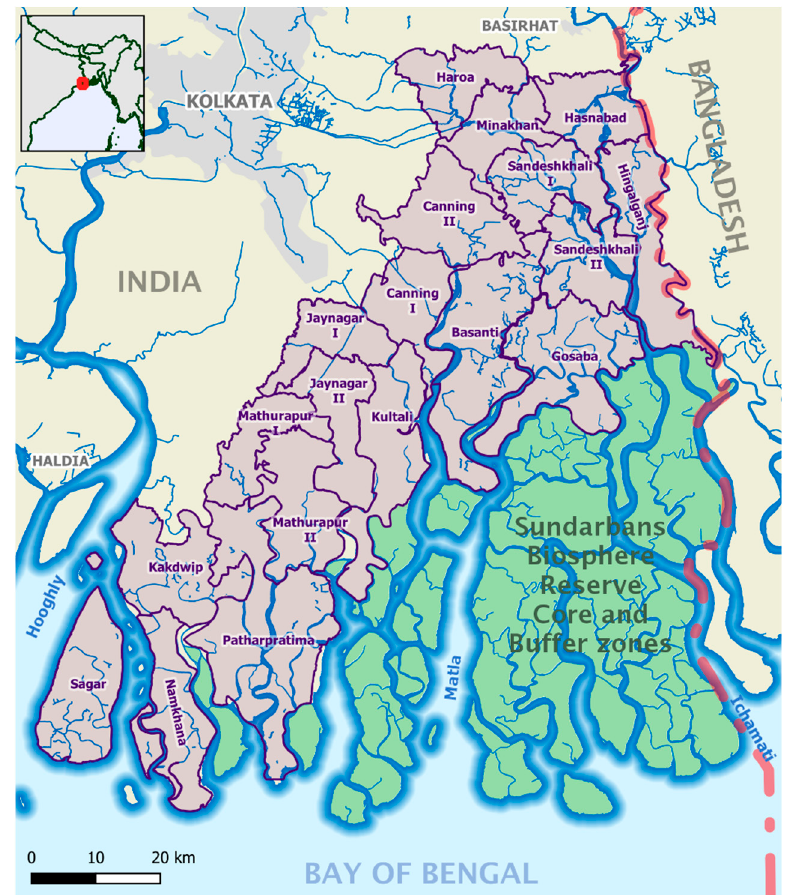
Figure 1. Sundarban Biosphere Reserve (SBR), West Bengal, India. The 19 blocks of the SBR Transition Zone, which comprise the populated study area, are shown in purple. The protected mangrove forest is shown in green.